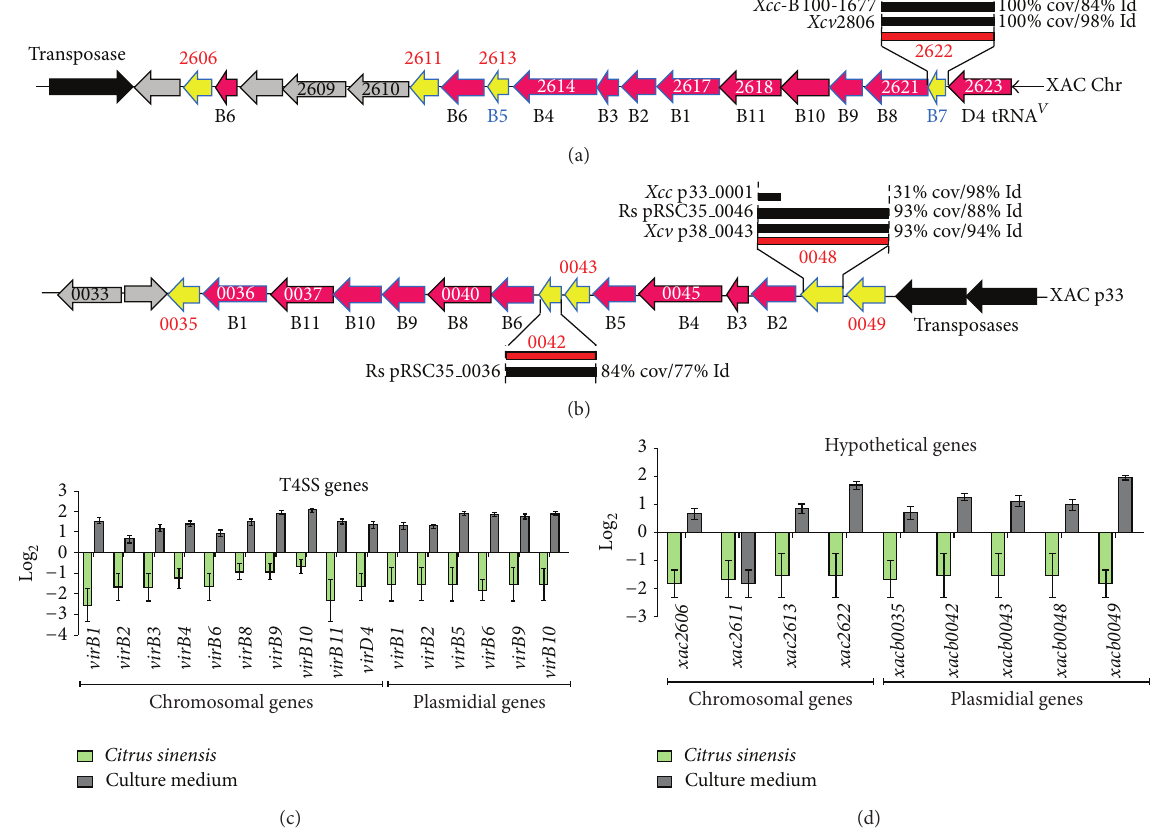
Figure 2: T4SS genes in Xanthomonas citri subsp. citri and their expression levels. Schematic representation of T4SS genes in Xanthomonas citri subsp. citri and their expression levels. (a) and (b) show functional maps of T4SS genes on the chromosome (a) and plasmid pXAC64 (b), respectively. The expression levels of genes in the T4SS (c) and ORFs localized near the virB genes (d) are indicated. Solid green bars indicate in vivo expression with respect to their expression in vitro (black bars). Error bars indicate standard deviation of the